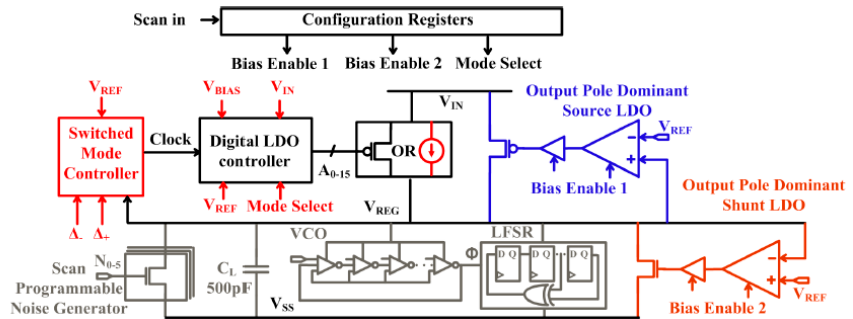
Figure 32. The architecture of Scan Reconfigurable Hybrid LDO [59].